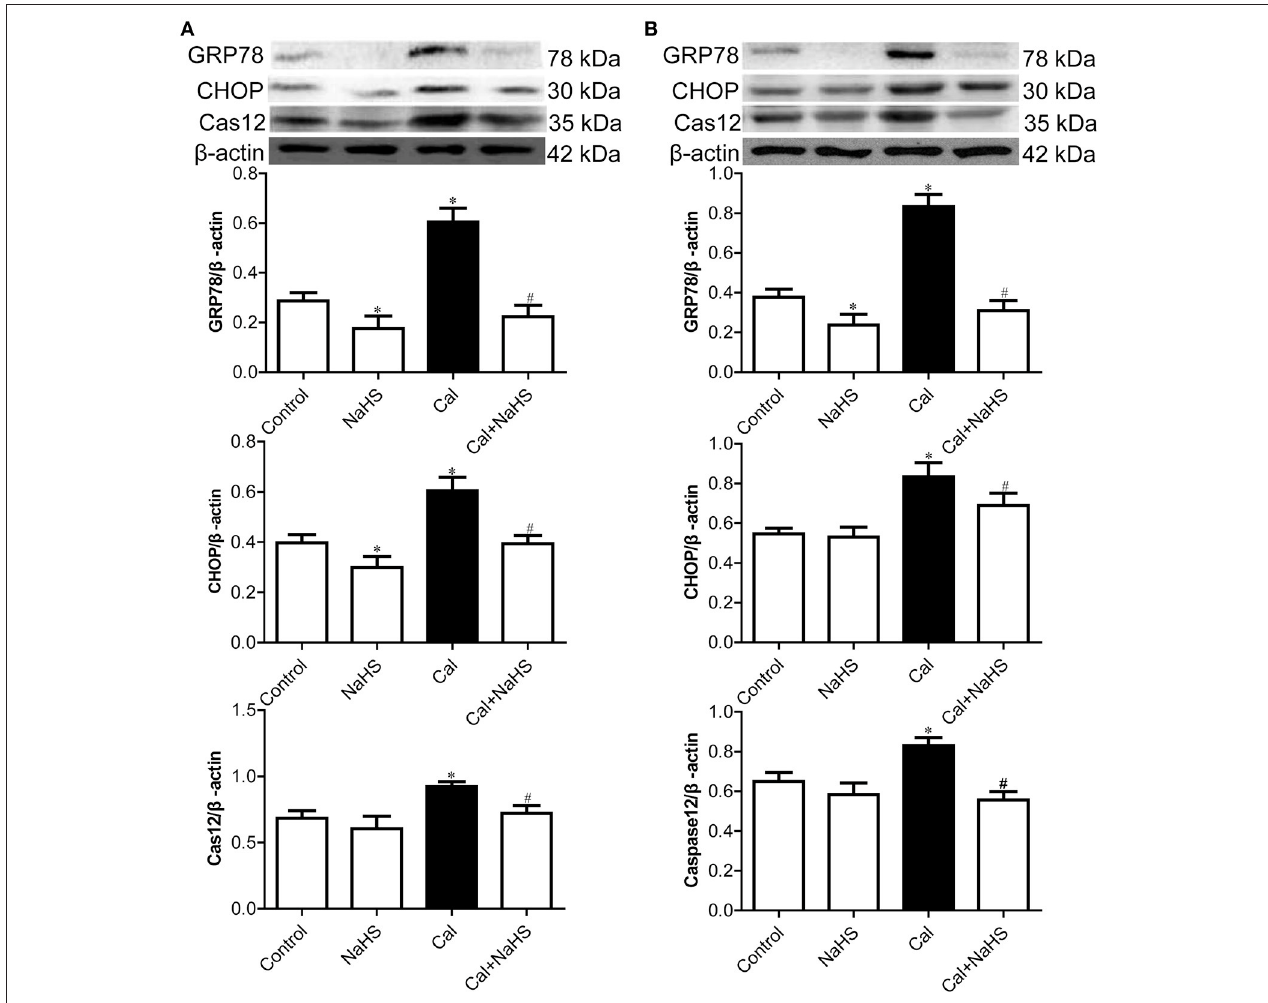
FIGURE 3 | Protein expression of endoplasmic reticulum stress markers in aorta (A) and carotid artery (B) . Data are mean ± SD. * P < 0.05 vs. control; # P < 0.05 vs. Cal. ( n = 8 each group).